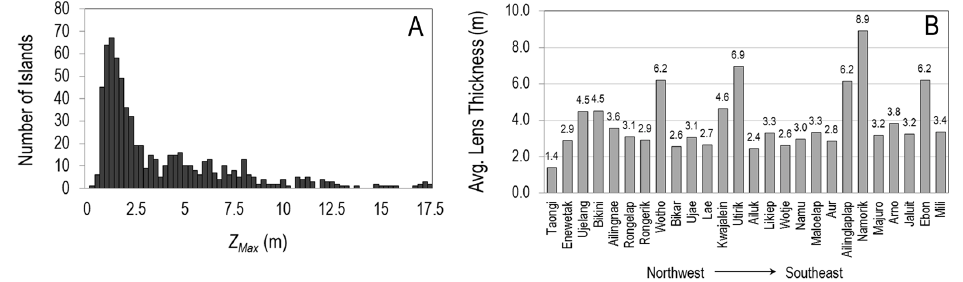
Figure 7. ( A ) Frequency distribution of Z max under average rainfall conditions for the 680 islands; ( B ) Average lens thickness ( Z max ) for each atoll in the RMI. Island values are shown according to their location in the northwest ‐ to ‐ southeast direction, which corresponds to the direction of increasing average annual rainfall.